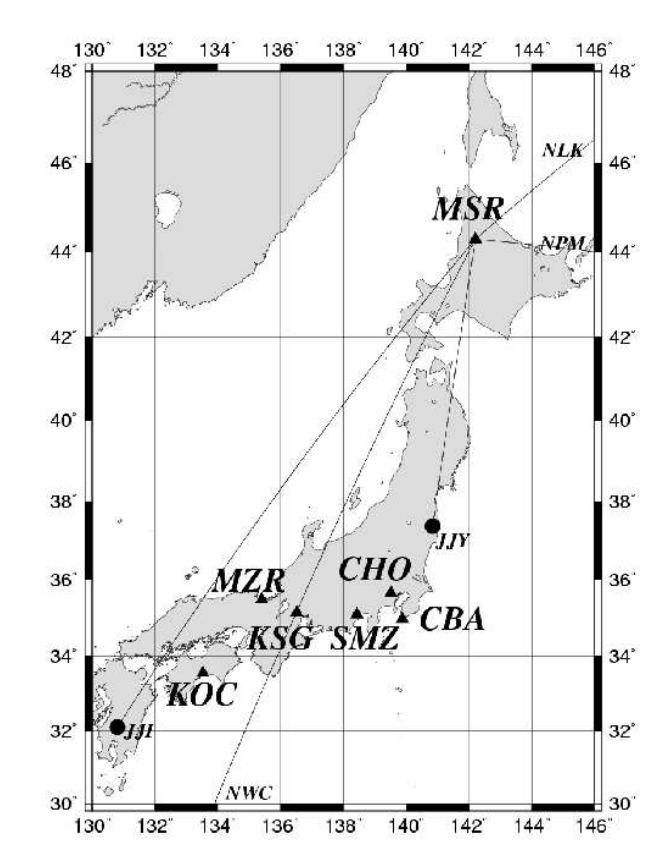
Figure 2. VLF/LF network in Japan. Several observing stations (Moshiri (abbreviated as MSR), Chofu (CHO), Chiba (CBA), Shimizu (SMZ), Kasugai (KSG), Maizuru (MZR), and Kochi (KOC)) and several VLF/LF transmitter signals detected at each station. The situation for one station (MSR) is indicated, and receiving transmitters are JJY, NWC, JJI, NPM and